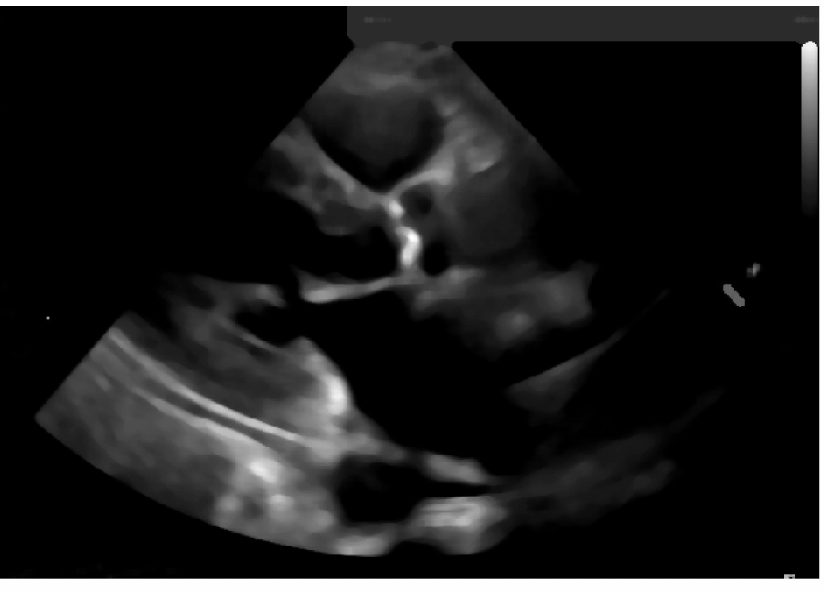
Figure 16. Blurred